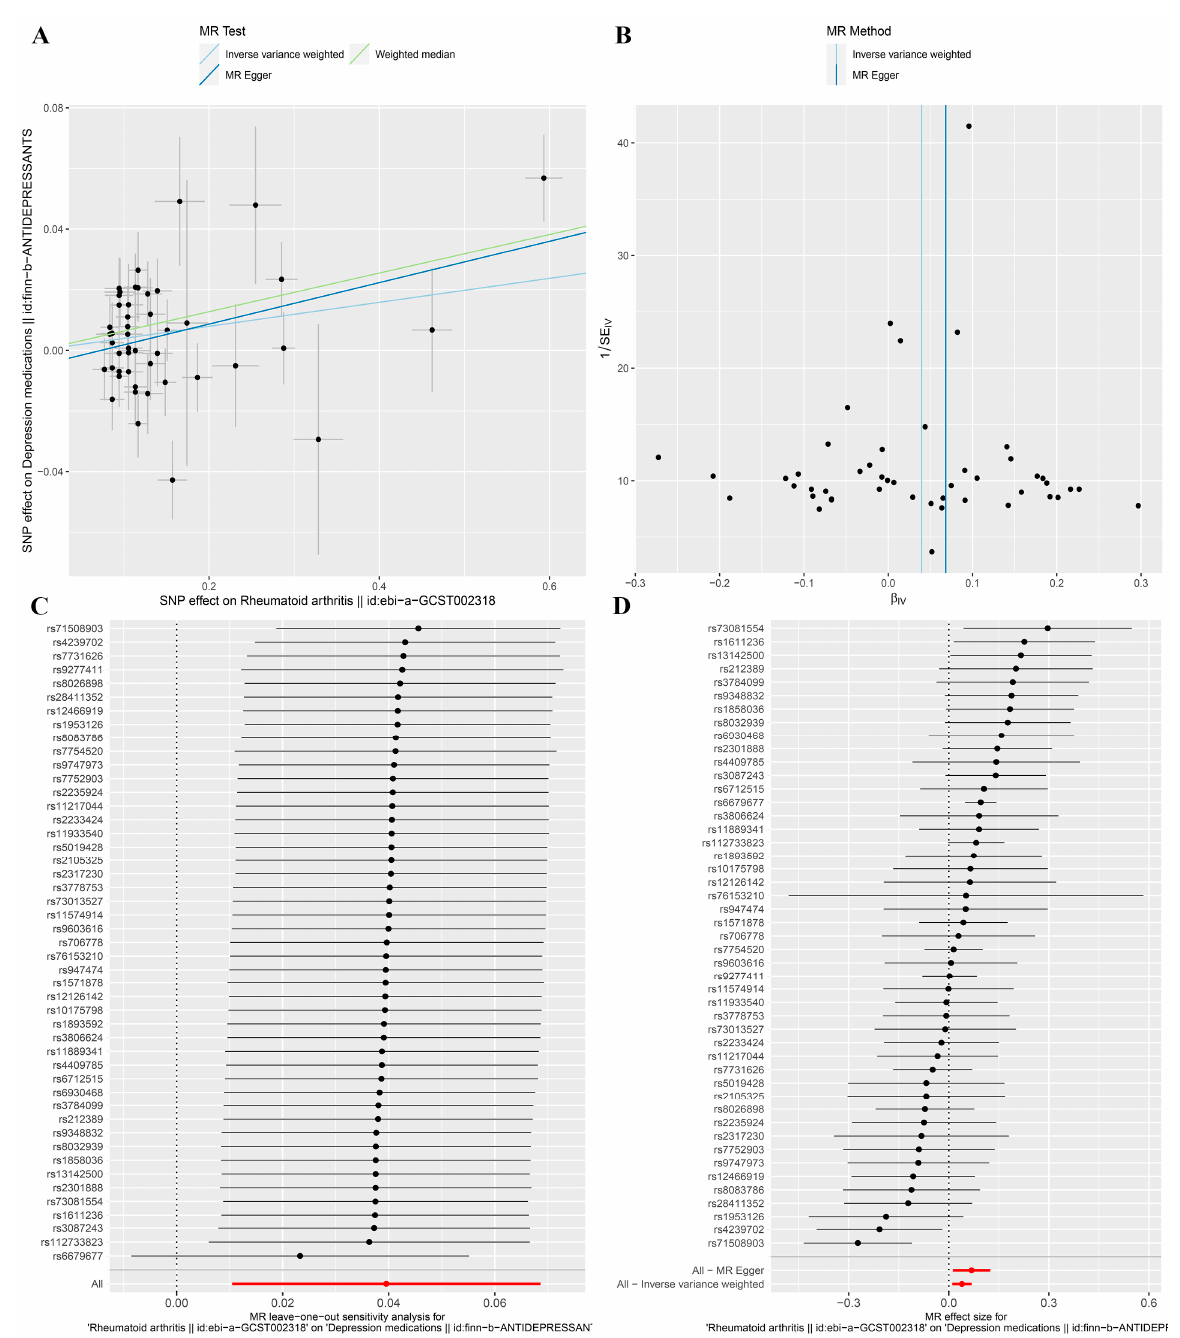
Figure 3. Association between genetically predicted rheumatoid arthritis and depression medications presented in ( A ) scatter plot, ( B ) funnel plot, ( C ) leave-one-out sensitivity analysis, and ( D ) forest plot. Table 2. The results of sensitivity analyses using multiple methods.